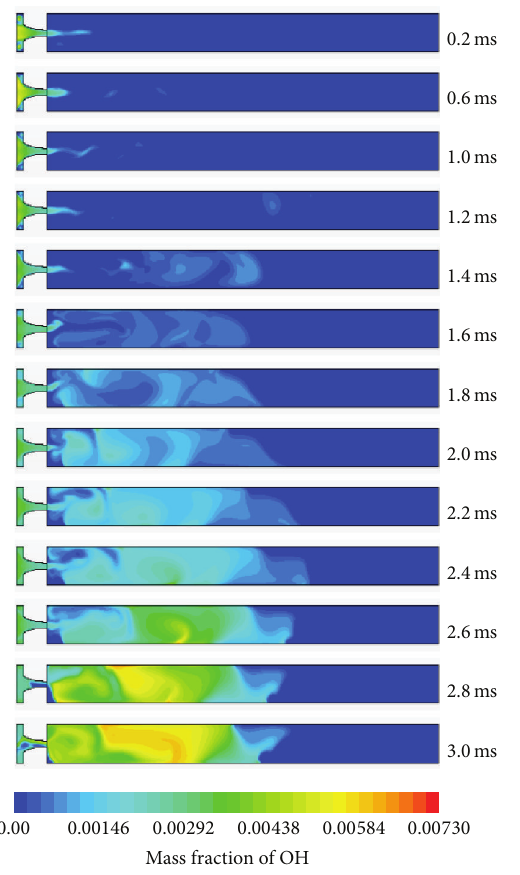
Figure 13: OH mass fraction during methane-air combustion predicted using DRM19 mechanism.